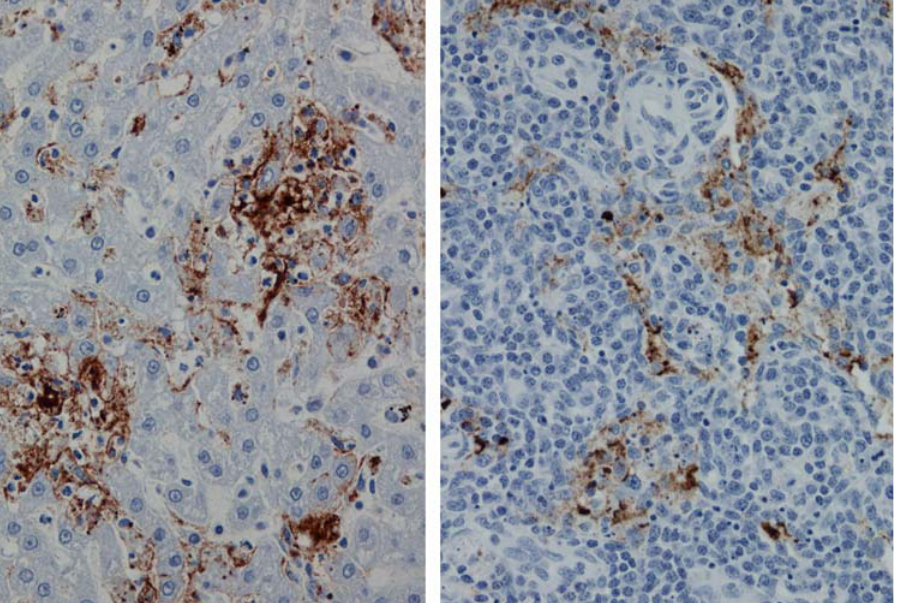
Figure 3. Tissues from SHIV-infected rhesus monkeys vaccinated with VSV D G/ZEBOVGP and challenged 31 days later with ZEBOV. (Left panel) Immunohistochemical staining of liver from animal that succumbed on day 9 (Subject 6) for ZEBOV. Note abundance of EBOV antigen (brown) associated with sinusoids. (Right panel) Immunohistochemical staining of lymph node from animal that succumbed on day 13 (Subject 5) for ZEBOV. Note localization of ZEBOV antigen (brown) associated with macrophages and dendritiform cells. Original magnifications, 6 20. doi:10.1371/journal.ppat.1000225.g003 PLoS Pathogens |